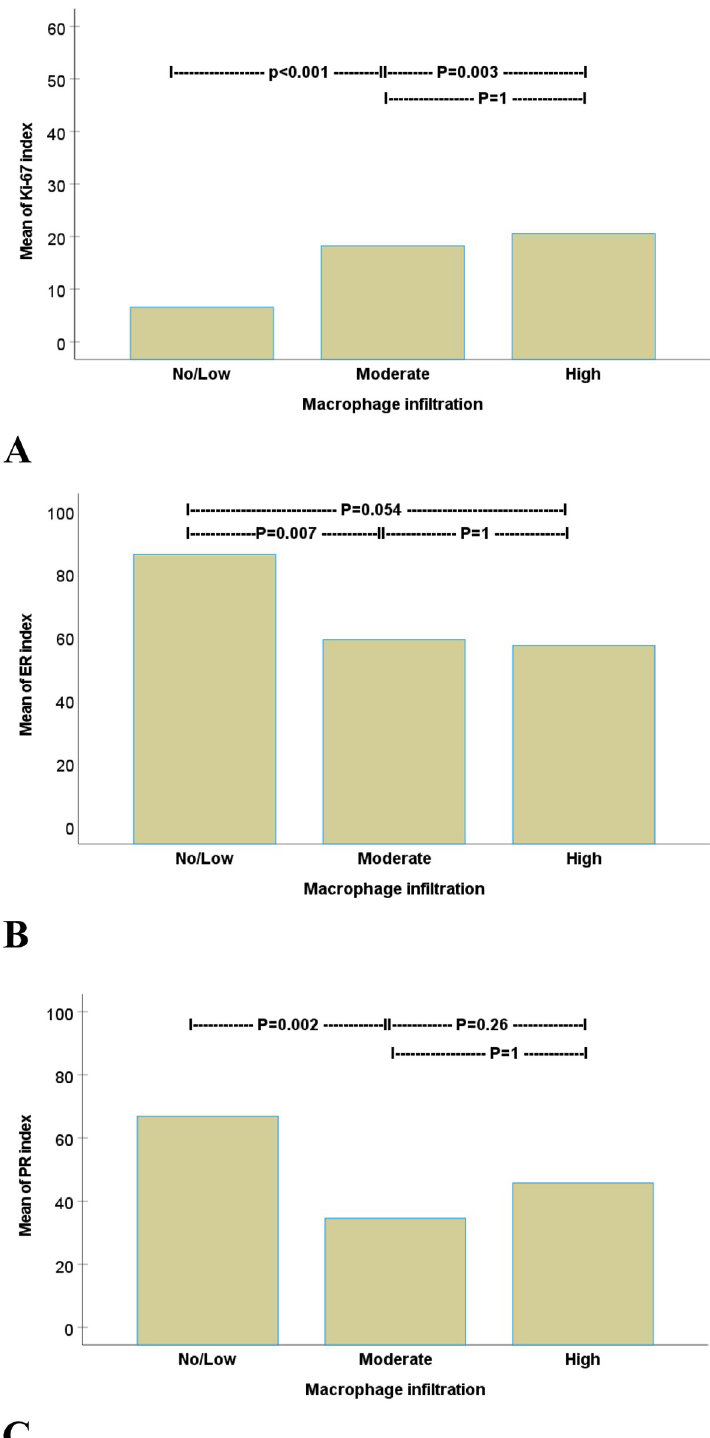
Fig 4. ANOVA analysis followed by Bonferroni’s post hoc test comparing macrophage infiltration in breast cancer in relation to (A) Ki-67, (B) ER, and (C) PR indexes.